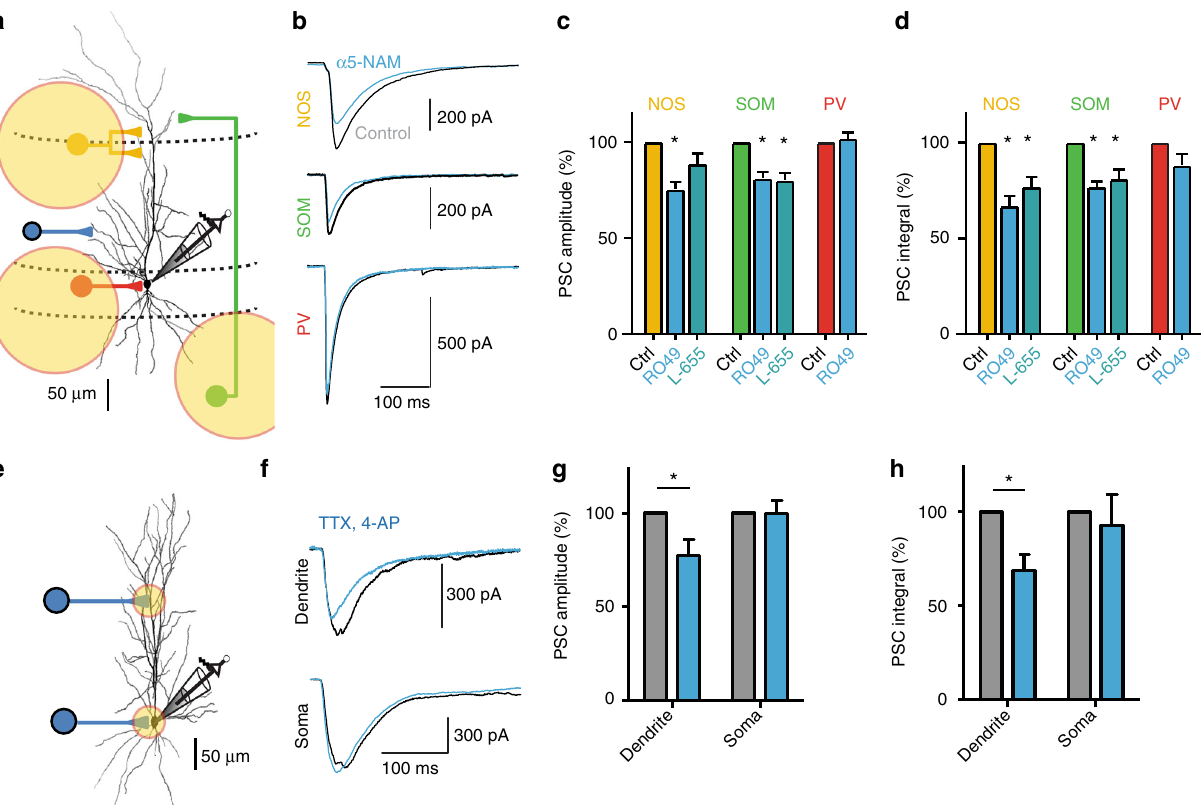
Fig. 3 SOM and NOS interneurons mediate dendritic inhibition via α 5-GABA A Rs. a Experimental design. Optogenetically targeted projections from local interneurons and the respective fi elds of illumination. b Light-evoked IPSCs from different interneuron populations (NOS, yellow; SOM, green; PV, red) were recorded at – 70 mV in the presence of 10 µ M NBQX and 25 µ M AP5 using a CsCl-based pipette solution. Representative mean IPSCs before and after addition of the α 5-NAM RO4938581 (1 µ M, blue) show that IPSCs evoked in dendrite-targeting interneurons (NOS and SOM) were reduced. c Group means of the normalized IPSC amplitude showed a signi fi cant reduction of NOS ( P < 0.001; paired t test, n = 8) and SOM-mediated IPSCs ( P < 0.01; n = 7) after the addition of RO4938581, while PV-mediated IPSCs were not affected ( P = 0.57, n = 8; paired t test). In addition, the effect of the α 5-IA L-655,708 (50 nM) on the amplitude of SOM ( P < 0.01, n = 6) and NOS IPSCs is shown ( P = 0.07, n = 7). d The mean normalized PSC integral was reduced after the application of both α 5-GABAR modulators for inputs from NOS and SOM interneurons (all: P < 0.05; paired t test, n = 8), while PV synapses were not affected ( P = 0.08, n = 8; paired t test). e Schematic of ChR2-assisted input mapping. f Responses to stimulation of dendritic (200 – 300 µ m from soma, top) and somatic inputs (bottom) before and after addition (blue) of the α 5-NAM. g , h Group means show a signi fi cant reduction in PSC amplitude and integral for dendritic inputs ( P < 0.05; paired t test, n = 8), but not for perisomatic synapses ( P > 0.6; n = 8). Recording temperature T ≈ 22